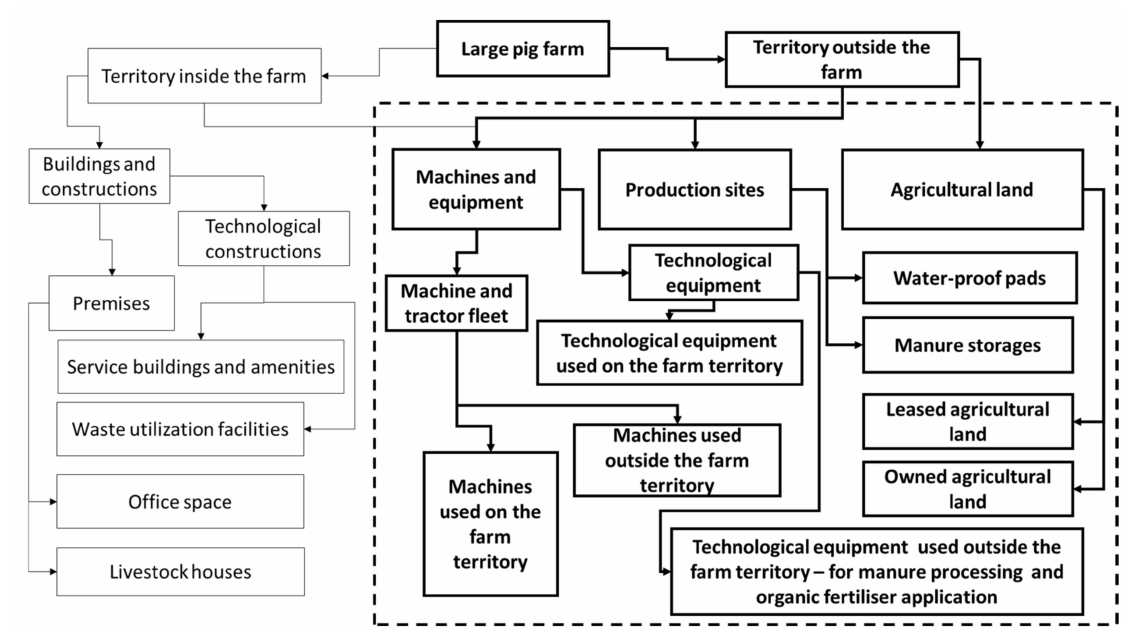
Figure 1. The structure of a large pig